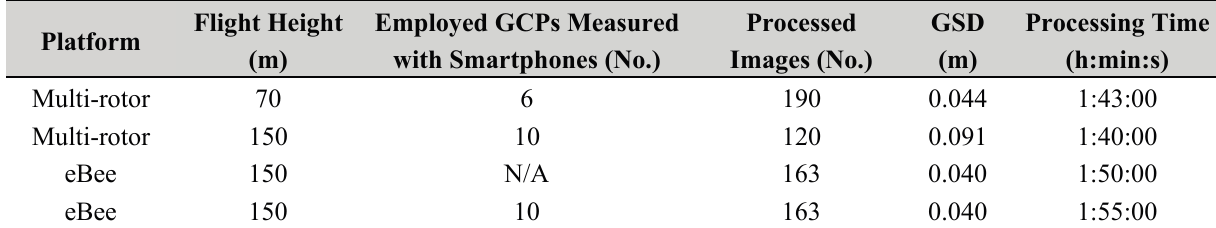
Table 5. Main settings of the image processing step in the